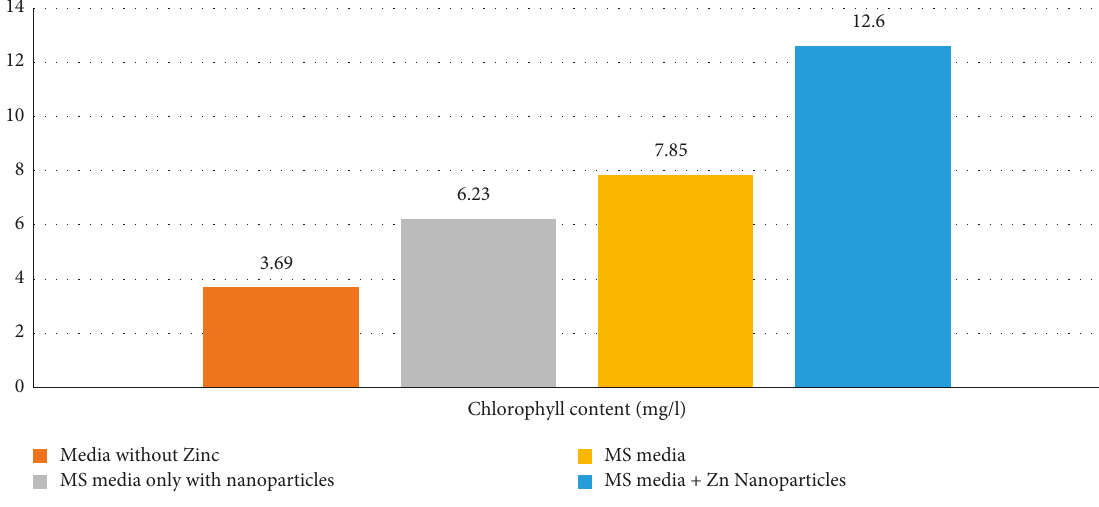
Figure 10: Chlorophyll content in several